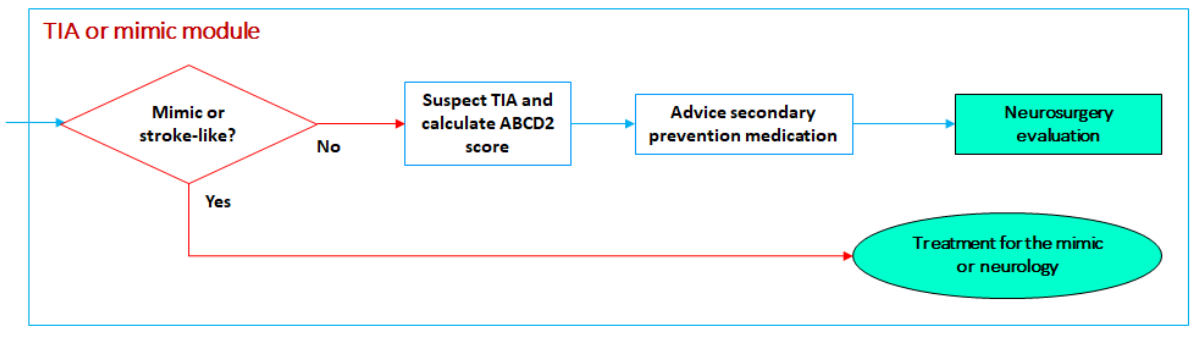
Figure 8. Transient ischemic attack (TIA) or mimic